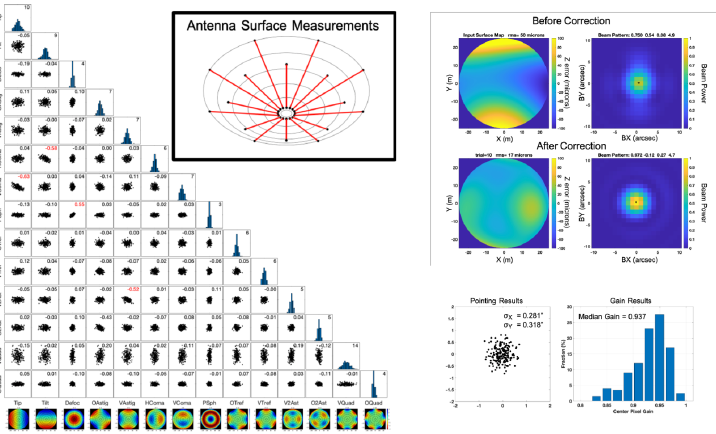
Figure 6. Monte Carlo simulation of LASERS, assuming that the surface is deformed from its parabolic shape along the optical axis using Zernike polynomials. The left panel shows the recovery of 14 Zernike coefficients from simulated distance measurements obtained according to the inset figure. The right-hand panel (upper) shows the improvement in the beam pattern after correction. The right panel (lower) shows the ability to recover possible pointing errors due to the misalignments within the primary and the distribution of errors in the recovered antenna